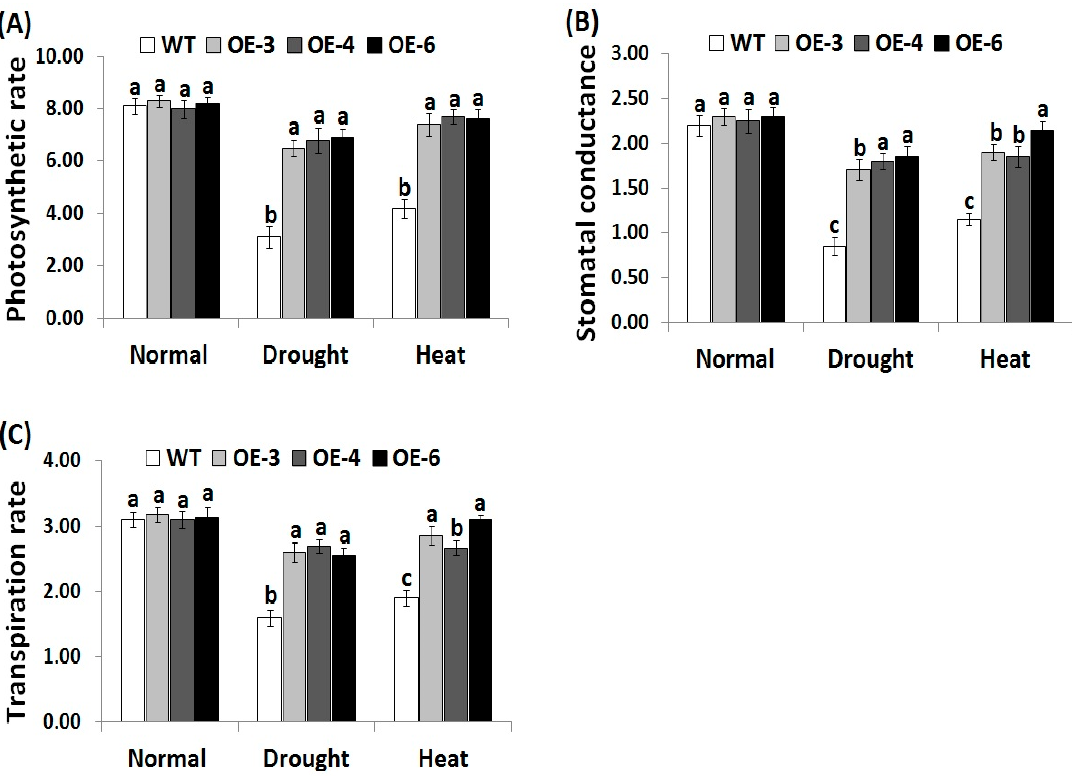
Figure 3. Photosynthesis rate ( P n , µ mol m 2 s − 1 ) ( A ), stomatal conductance ( g s , mol m 2 s − 1 ) ( B ), and transpiration rate ( E , mmol m 2 s − 1 ) ( C ) of the wild-type and transgenic rice plants overexpressing OsRab7 subjected to normal, drought, and heat stress conditions. Data are means ± SE ( n = 3). Different letters above the columns indicate significant differences ( p ≤ 0.05).